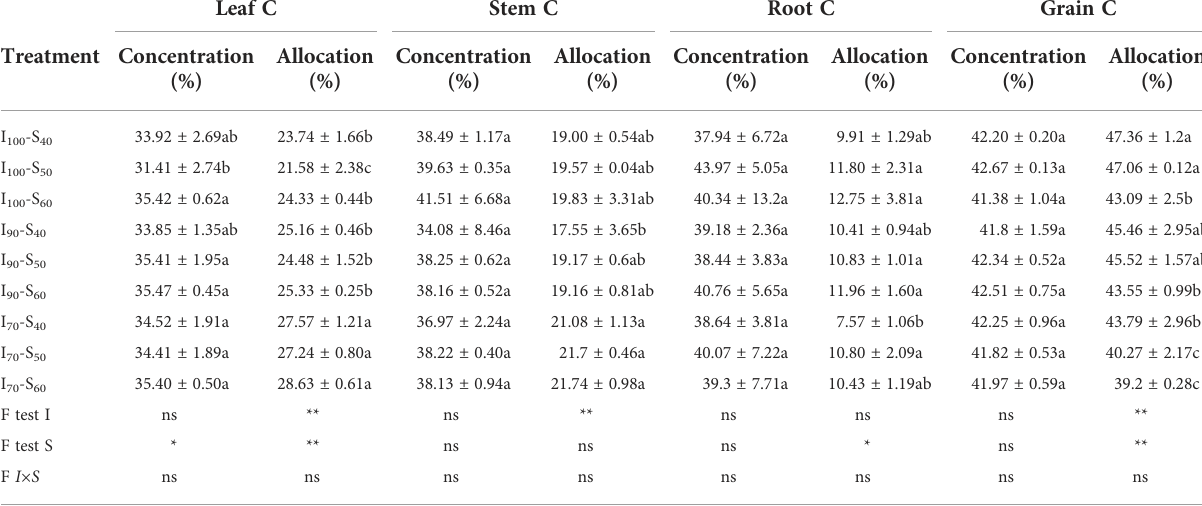
Valuesaremean±S.D.(n=4)foreachmeasurement.I 70 ,I 90 andI 100 representirrigationregimesof fl oodingwith30mm(upperlimit)asthesoilwaterreaches70%ofsaturation(lowerlimit); fl ooding with30mm(upperlimit)asthesoilwaterreaches90%ofsaturation(lowerlimit)and fl oodingwith30mm(upperlimit)asthesoilwaterreaches100%ofsaturation(lowerlimit).S 40 ,S 50 ,andS 60 indicate soil clay content with 40%, 50% and 60% respectively. Different letters mean signi fi cant differences (p<0.05) according to the Duncan ’ s test. I, S, and I×S indicate irrigation regime, soil type, and the interaction between irrigation regime (I) and soil type (S), respectively. ns, *, ** and represent no signi fi cance, 0.01<p<0.05, and p<0.01,